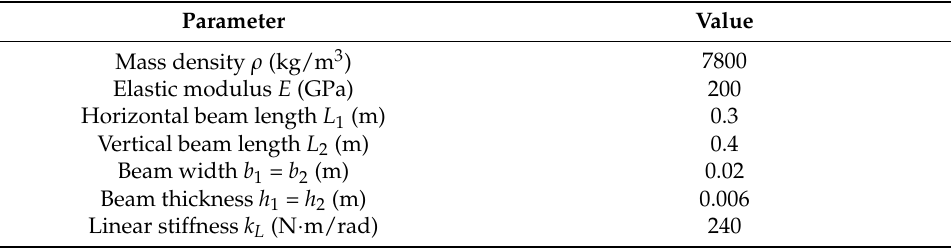
Table 1. Parameter values of L-shaped multi-beam